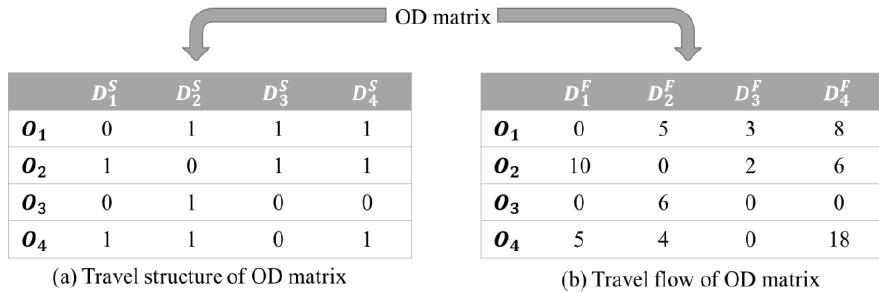
Figure 1. Travel spatial structure and travel flow of OD matrix. ( a ) Travel structrue of OD matrix. ( b ) Tavel flow of OD matrix.